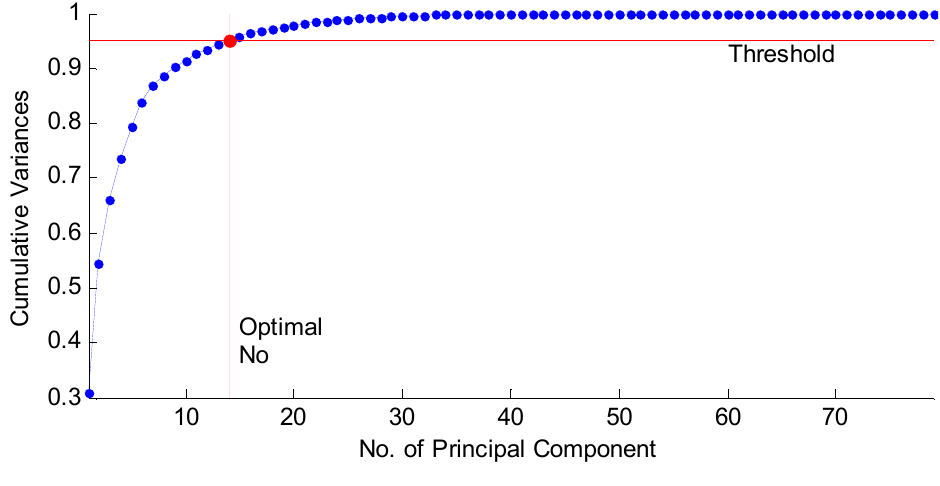
Figure 8. Feature selection via PCA (threshold is set as